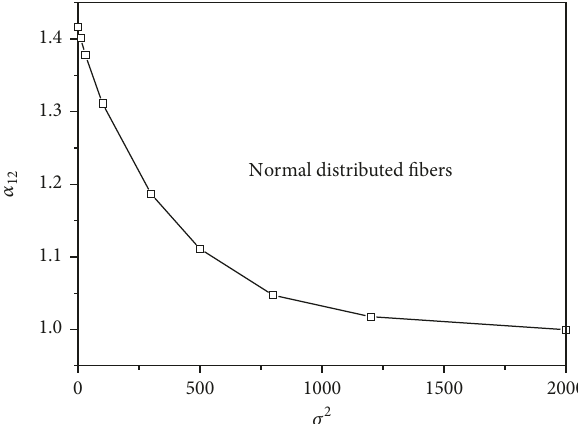
Figure 9: Relationship between the isotropic factor 𝛼 12 and variances 𝜎 2